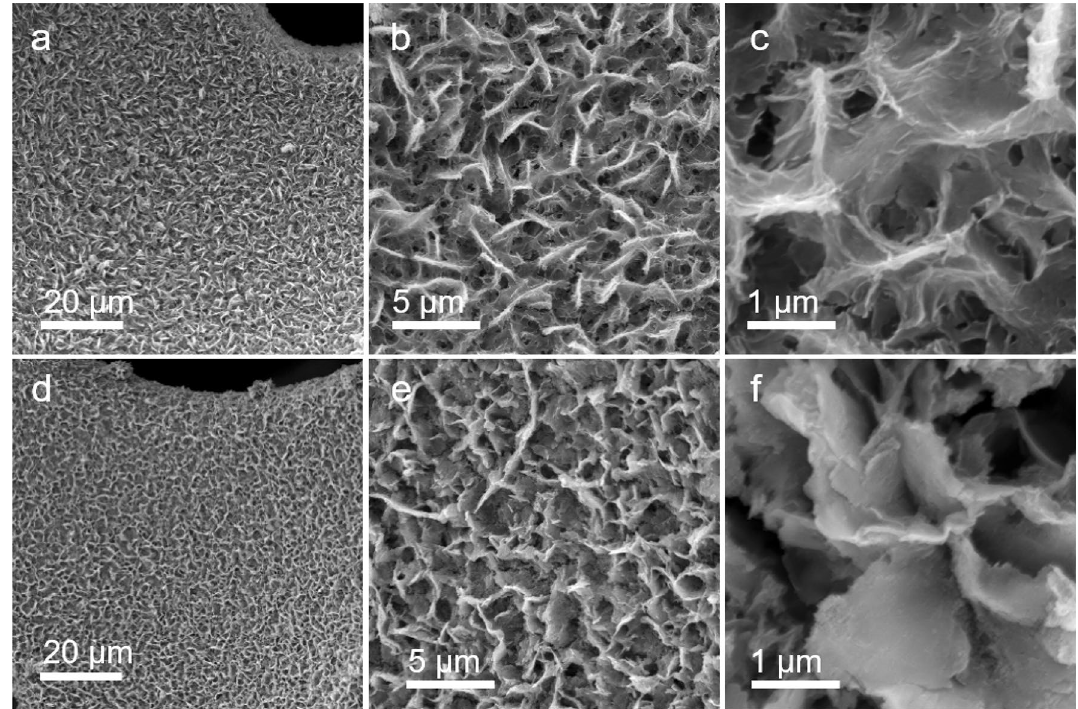
Figure 2. SEM image of Ni-MOF/NF ( a – c ) and Ni 2 P@Ni-MOF/NF ( d , e ) under different